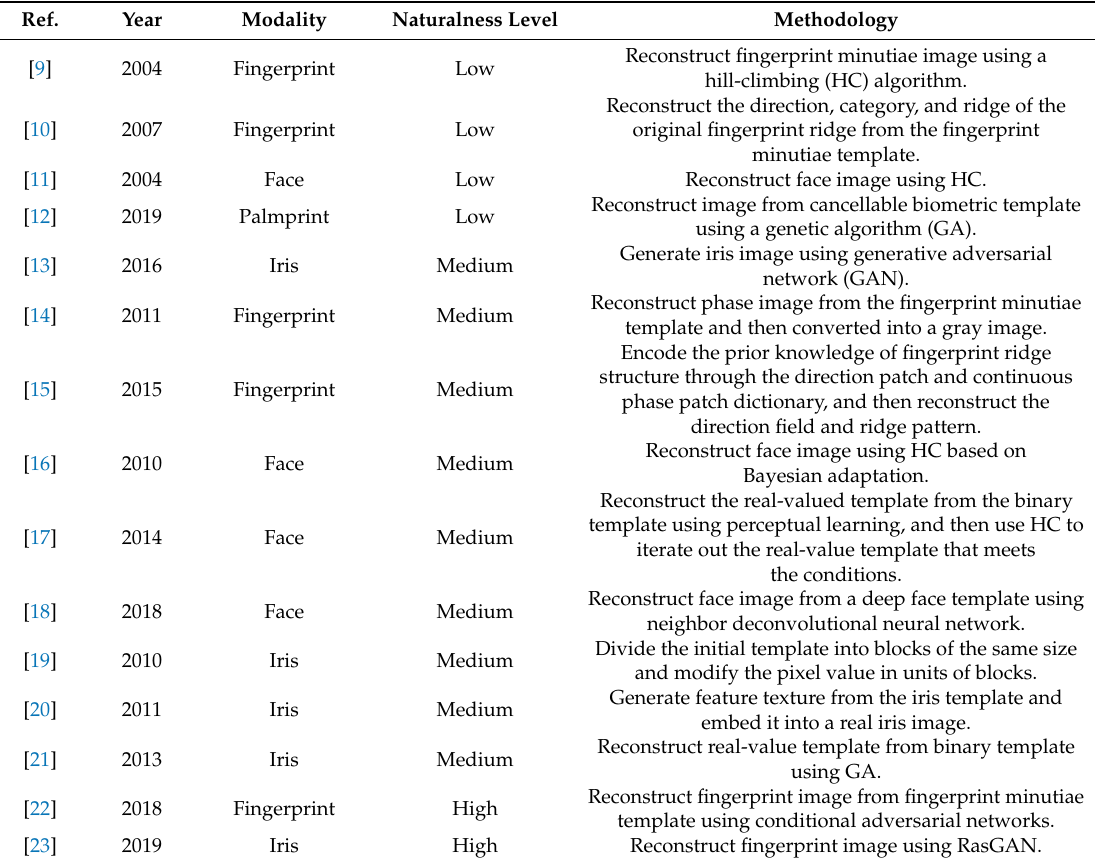
Figure 6. Counterfeited fingerprint images with the naturalness of different levels. The state-of-the-art biometric image-level attacks are summarized and compared in Table 2. Table 2. Existing biometric image-level attacks.